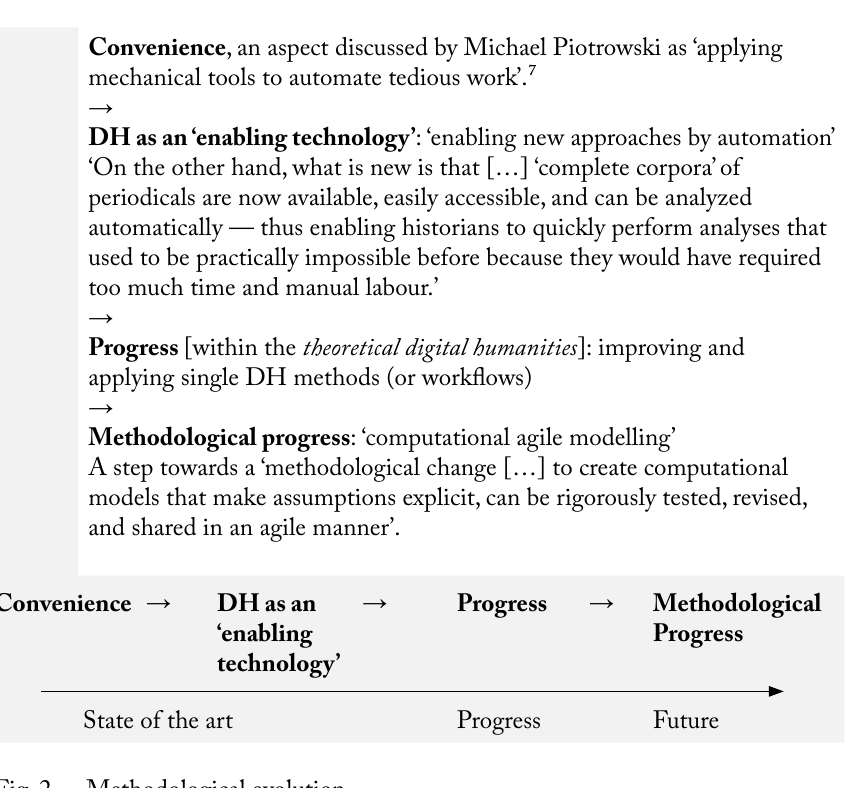
Fig. 2 Methodological